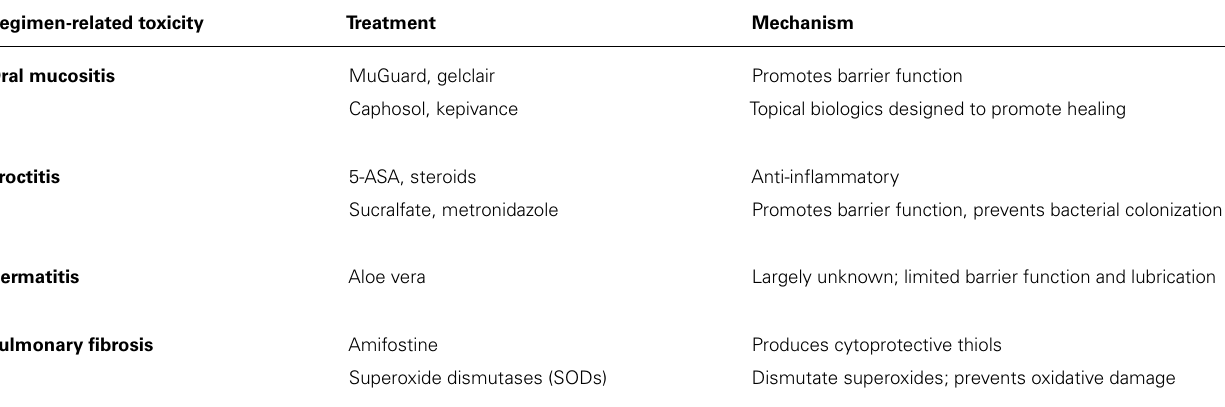
Table 1 | Current standard of care therapies for common regimen-related